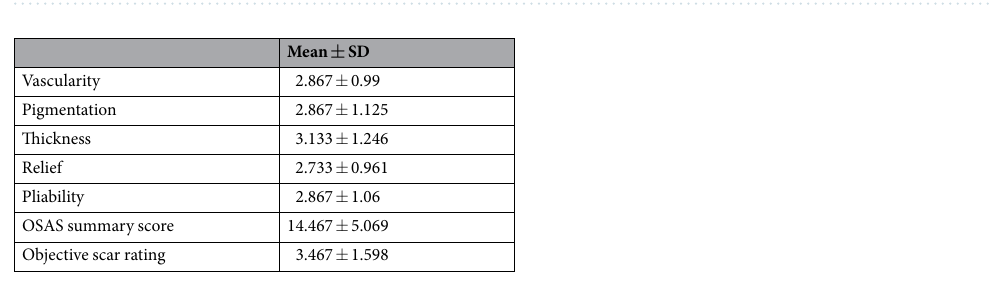
Table 6. Mean values of the Observer Scar Assessment Scale (OSAS). SD, standard